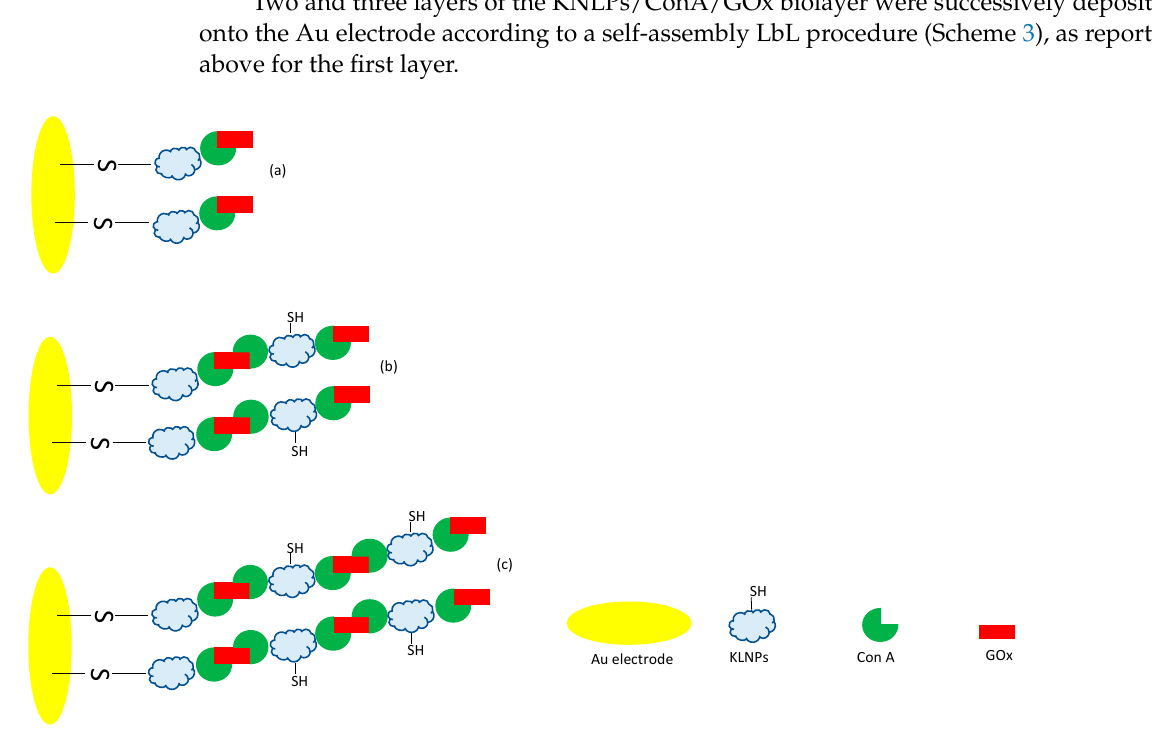
Scheme 3. Schematic of the layer-by-layer (LbL) deposition process. Gold electrodes were successively functionalized with one ( a ), two ( b ) and three ( c ) layers of KLNPs, ConA and GOx by direct adsorption.